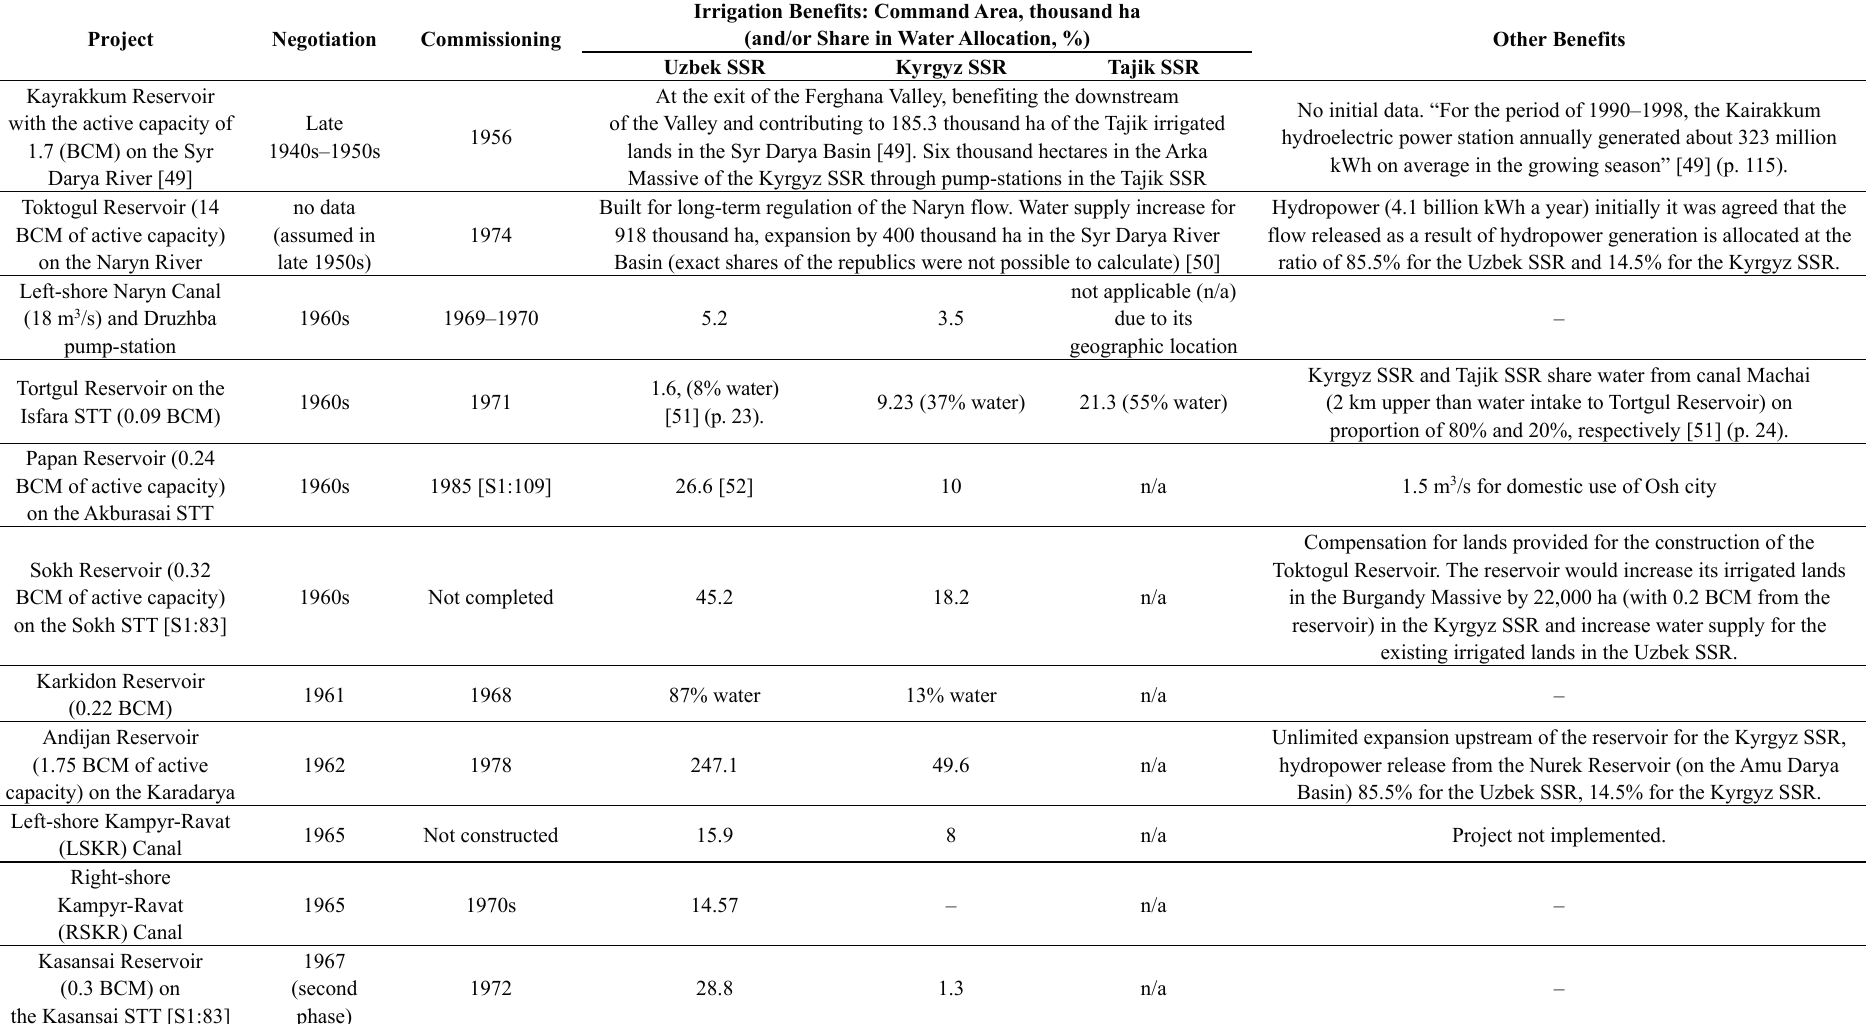
Table 2. Projects with shared benefits in the Ferghana Valley initiated/constructed between 1953 and